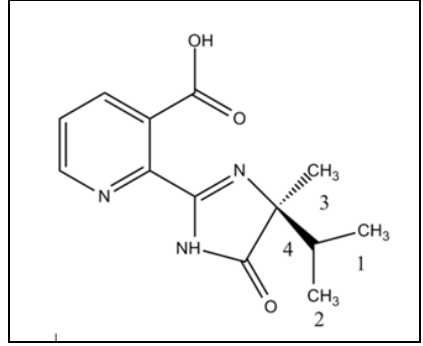
Figure 1. Chemical structure of imazapyr herbicide.